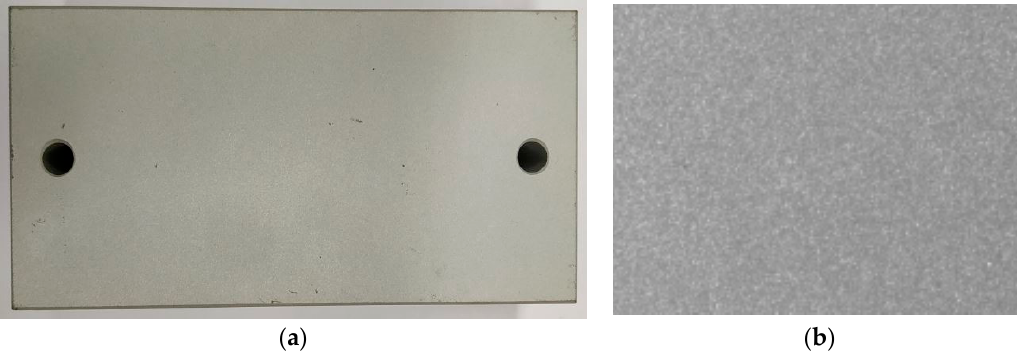
Figure 7. Calibration target design for dual camera image mapping: ( a ) white painted aluminum target; ( b ) captured speckle image using the vertical camera.